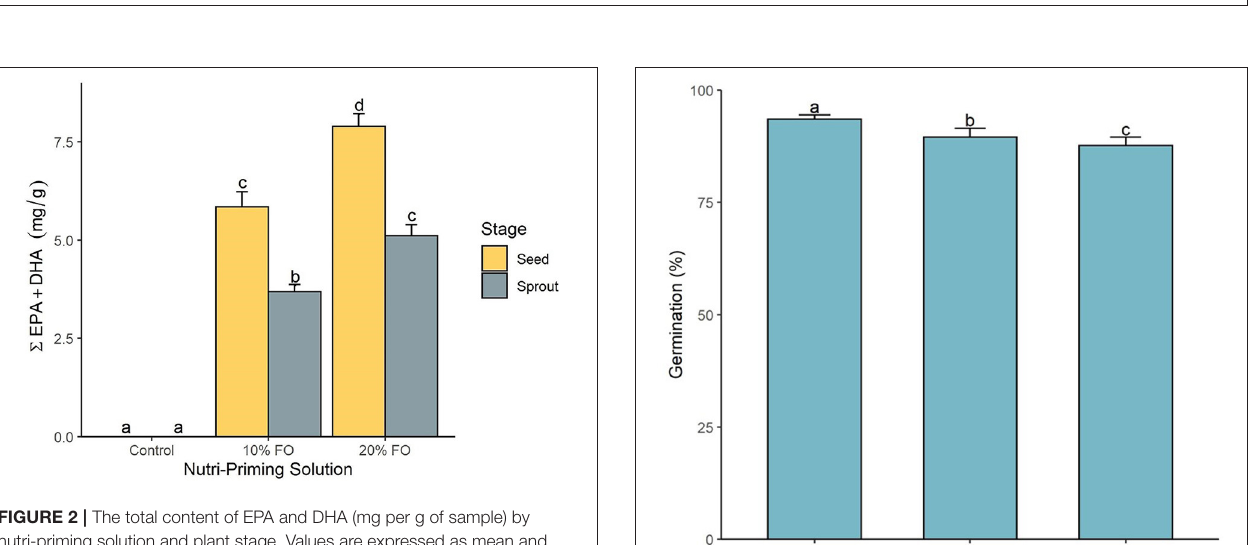
FIGURE 1 | Principal component analysis of FA content (mg per g of sample) of flax seeds and sprouts by nutri-priming solution. Samples are color-coded by nutri-priming treatment (control, 10% fish oil (FO), and 20% FO) and shapes signify plant sage (seed or sprout).